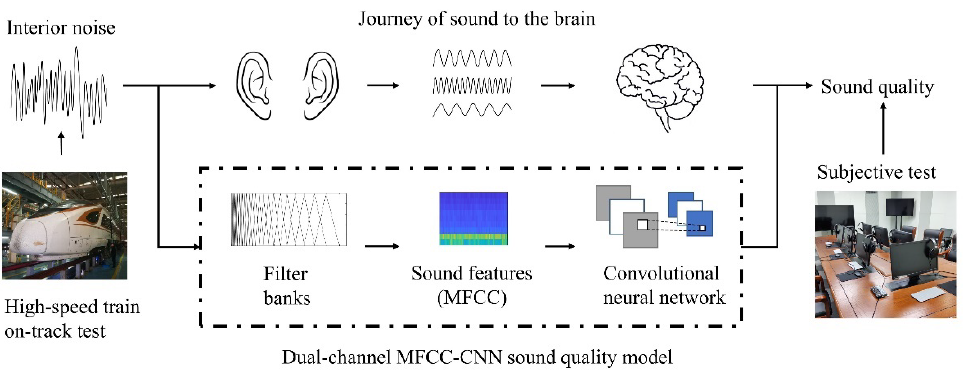
Figure 1. The basic structure of the binaural MFCC-CNN sound quality model.